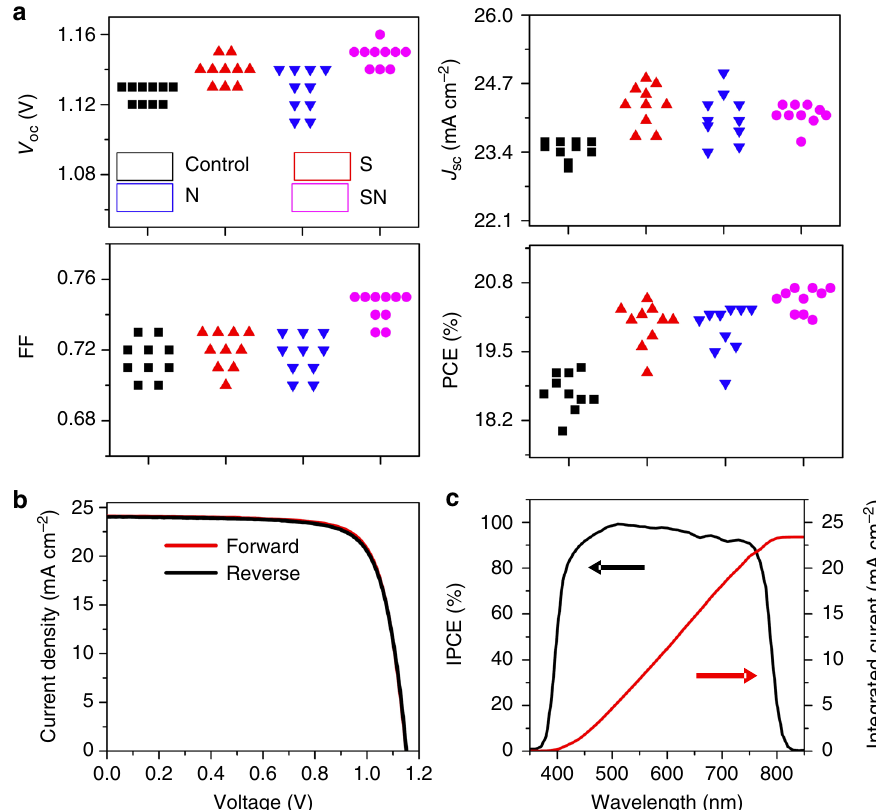
Fig. 4 Photovoltaic characterization. a PV metrics of perovskite solar cells with different modulators. All J - V curves recorded at a scanning rate of 50 mV s − 1 in reverse direction under standard AM 1.5G solar radiation, unless stated otherwise. PV metrics are summarized in Supplementary Tables 2 – 6. b J – V curves of the champion cell containing SN recorded in reverse (from V OC to J SC ) and forward (from J SC to V OC ) scanning directions under standard AM 1.5G solar radiation. The photovoltaic metrics derived from the two J – V curves are shown in the inset. c The corresponding IPCE spectrum (black curve) with the projected photocurrent (red curve) derived from integrating the IPCE over the standard AM 1.5G spectral